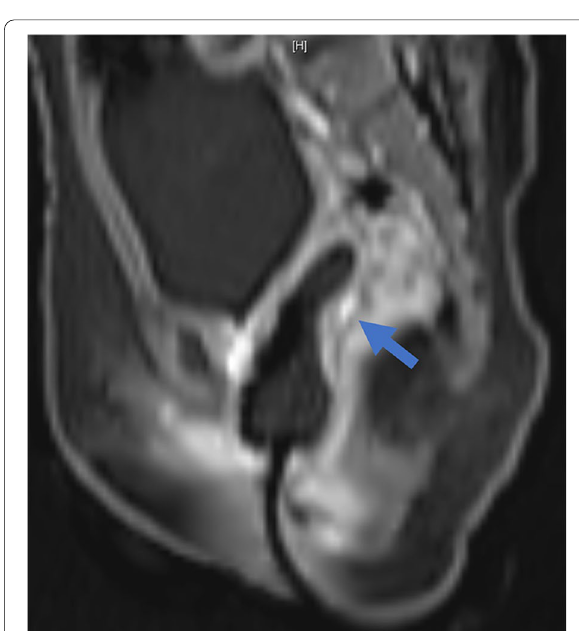
Fig. 3 Gadolinium-enhanced magnetic resonance imaging of the tumor before total resection. Preoperative imaging reveals a residual tumor on the posterior wall of the vagina. The vagina is inflated with saline solution. Arrow: the tumor of